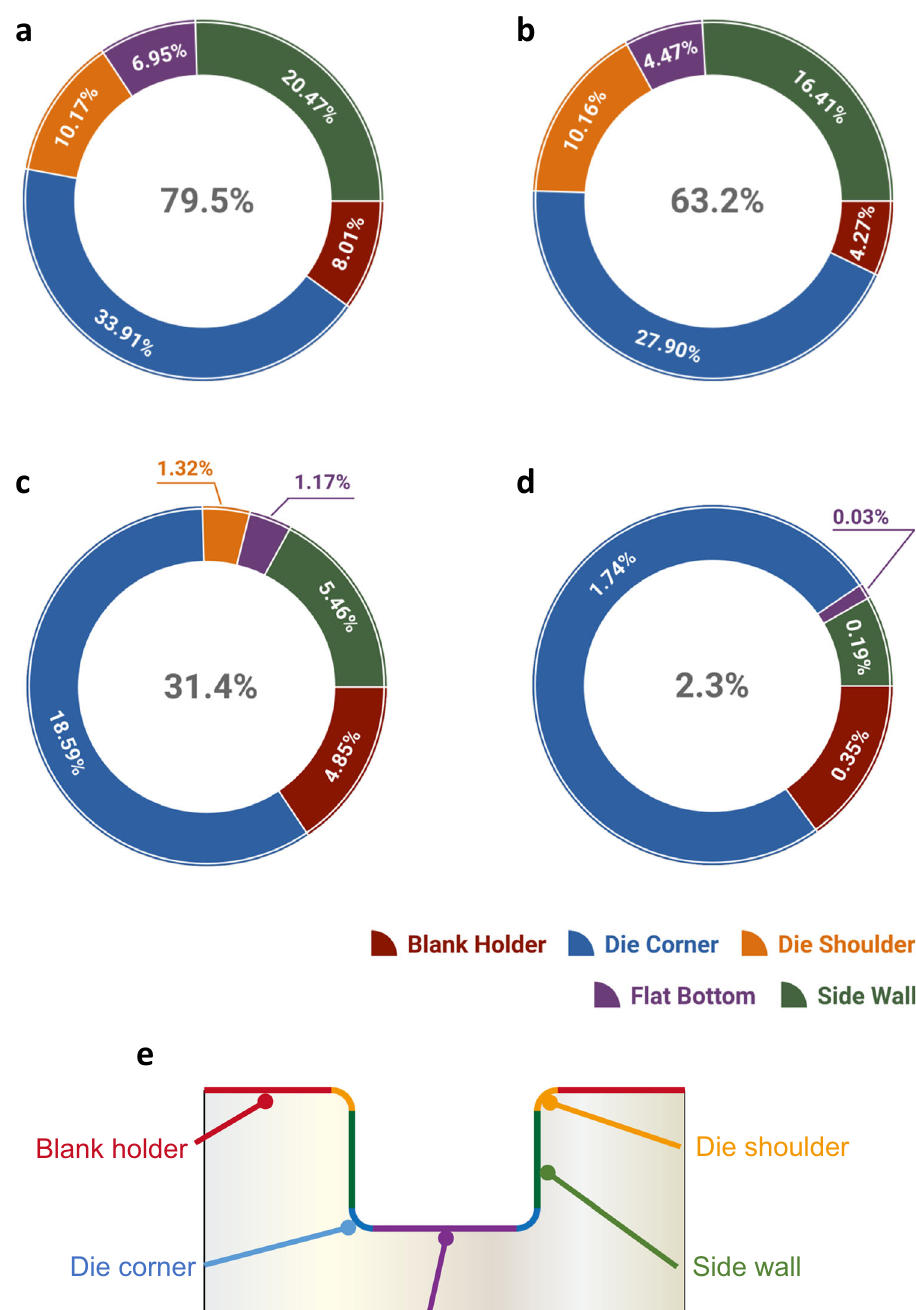
Fig. 4 | Digitally enhanced evaluation of four lubricants applied in the hot stamping process via data distribution analysis of the lubricant failure area (gradeslessthan30%).a Lubricant #1. b Lubricant #2. c Lubricant #3. d Lubricant